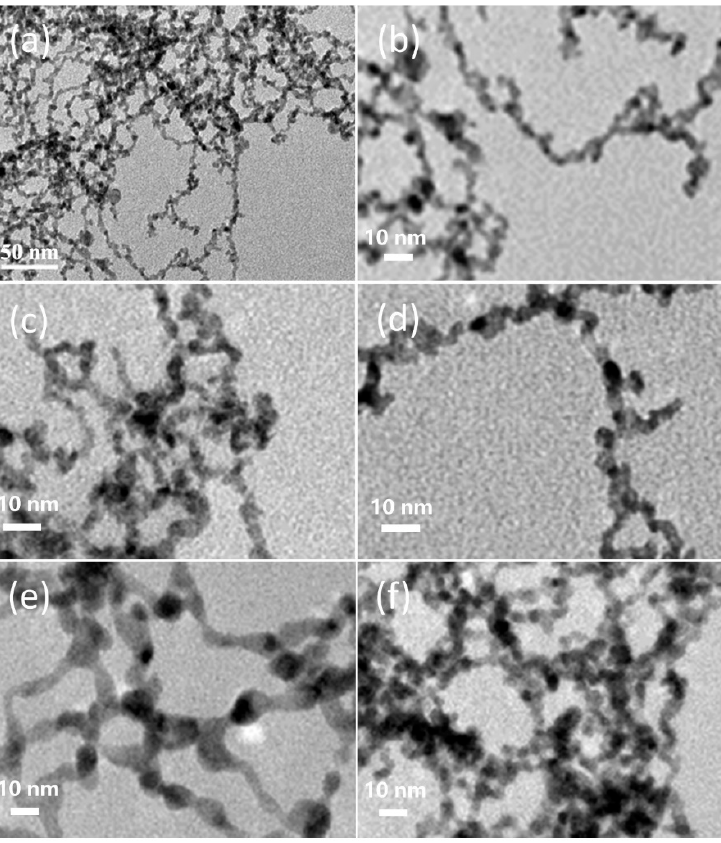
Figure 1. TEM images of ( a , b ) Pt 50 Pd 50 , ( c ) Pt 20 Pd 80 , ( d ) Pt 80 Pd 20 , ( e ) Pd, and ( f ) Pt aerogels.